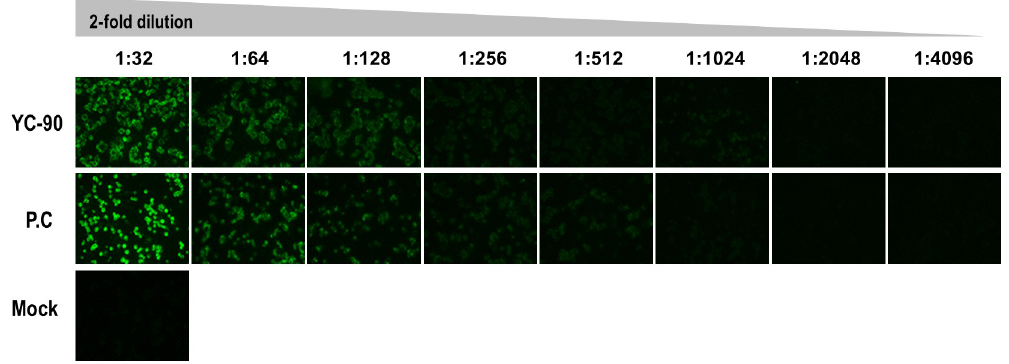
Fig 2. Detection of anti-SFTSV IgG using indirect immunofluorescence assay in serum of a forest worker; YC-90 (forest worker serum), P.C (serum from a PCR-confirmed SFTS patient), and mock (serum from a healthy donor without any history of